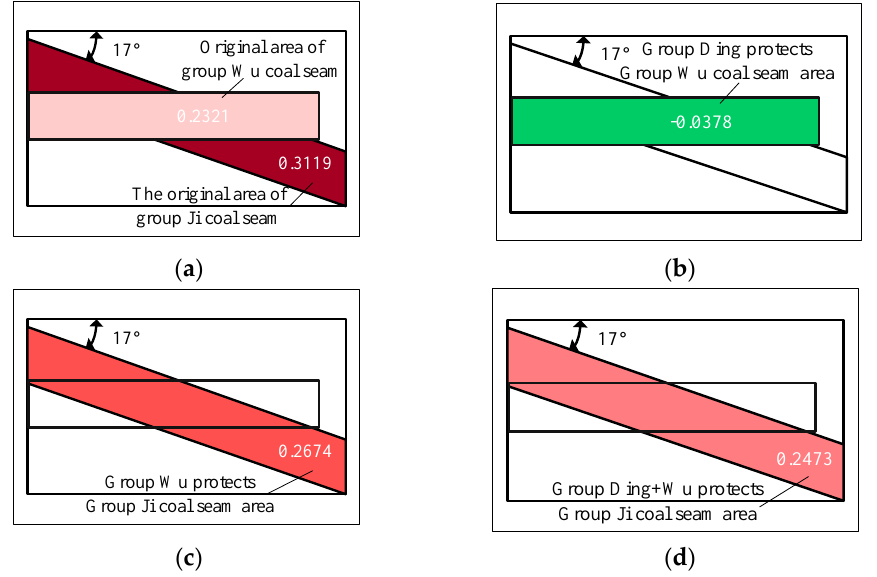
Figure 10. Quantitative results before and after mining of the protective layer in the evaluation area: ( a ) before the protective layer mining; ( b ) group Ding protects group Wu coal seam region; ( c ) group Wu protects group Ji coal seam region; ( d ) group Ding + Wu protects group Ji coal seam